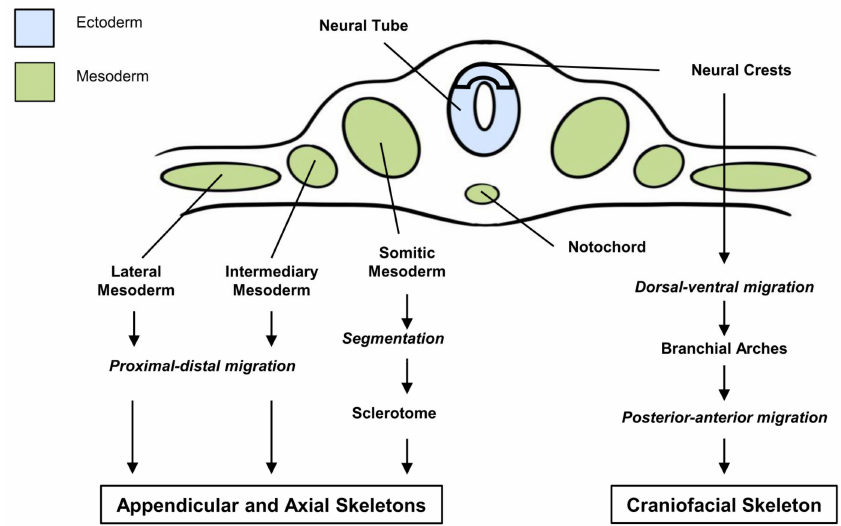
Figure 2. Origins of appendicular, axial and craniofacial skeletons. The axial and appendicular skeletons derive from cells of the paraxial mesoderm following a proximal-distal migration of cells from the lateral and intermediary mesoderm or the segmentation of cells from the somatic mesoderm. The craniofacial skeleton derives from the ectoderm cells of the neural crests following a dorsal-ventral migration, enabling the formation of the branchial arches and a posterior-anterior migration.